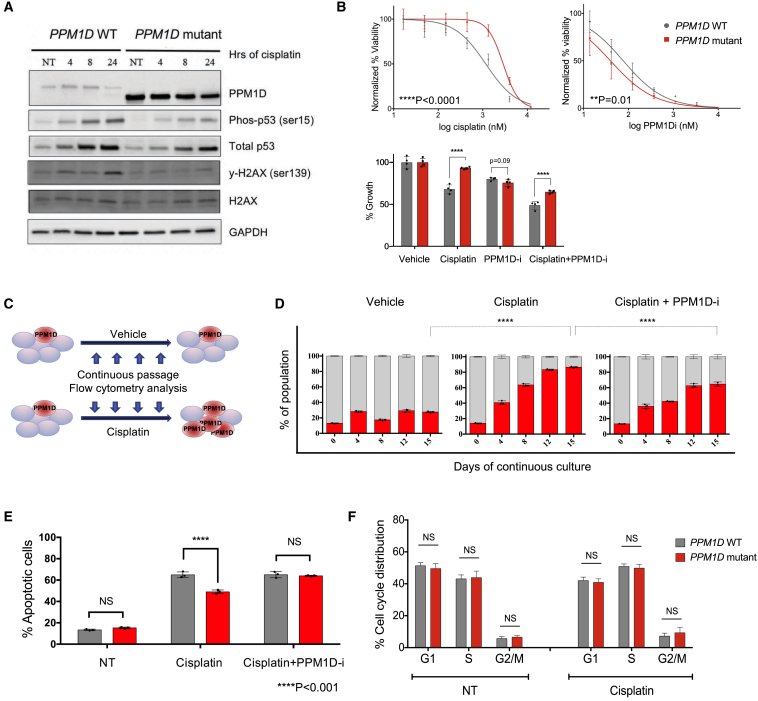
PPM1D Mutants Resist Cisplatin-Induced Apoptosis(A) Immunoblot of PPM1D WT and mutant HEK293 cells in the presence and absence of DNA damage. Cells were treated with 30 μM cisplatin, harvested at 4, 8, and 24 hr, and probed with the indicated antibodies. A composite of images is shown (see STAR Methods for details).(B) Top: dose-response curves for cell viability with cisplatin and a specific PPM1D inhibitor (GSK2830371) in WT and PPM1D mutant MOLM13 lines. Mean ± SD (n = 3) is shown along with a non-linear regression curve. All values are normalized to the baseline cell viability with vehicle, as measured by the WST-8 assay. The IC50 of cisplatin was 1.2 μM and 2.8 μM for the PPM1D WT and mutant lines, respectively (p < 0.001). Bottom: cell viability measured with WST-8 under combination treatment with cisplatin (1 μM) and GSK2730371 (a PPM1D inhibitor; 250 nM).(C) Schematic of experimental strategy shown in (D). GFP-negative PPM1D mutant cells were mixed with GFP-positive control cells at a starting ratio of 20:80 and subjected to treatment with vehicle (water) or cisplatin (+/− 18 nM GSK2830371). Population dynamics were assessed by flow cytometry every 4 days for 15 days.(D) Each bar depicts the proportion of PPM1D WT cells (in gray) and mutant cells (in red) in culture, measured at the indicated time points. Data represent mean ± SD of triplicates (n = 3). At least three independent experiments were conducted for each experiment shown above, with similar findings. The corresponding flow cytometry plots are depicted in Figure S3A.(E) PPM1D mutations confer resistance to cisplatin-induced apoptosis. PPM1D WT and mutant cells were treated with 1 μM cisplatin (+/− 24nM GSK2830371) for 72 hr, incubated with annexin V-APC and 7-AAD, and analyzed using flow cytometry. The percentage of annexin V positive (late and early apoptotic) cells is represented in the histogram (mean +/− SD shown). The experiment was performed in triplicate (n = 3).(F) PPM1D WT and mutant cells were treated with 750 nM cisplatin (or vehicle) for 24 hr and fixed for BrdU cell-cycle analysis. Anti-BrdU FITC antibody and propidium iodide (PI) were used to distinguish cells with active synthesis and DNA content, respectively. Mean values and SD are shown (n = 6). Three independent experiments were performed with similar findings.See also Figures S2, S3, and S4.